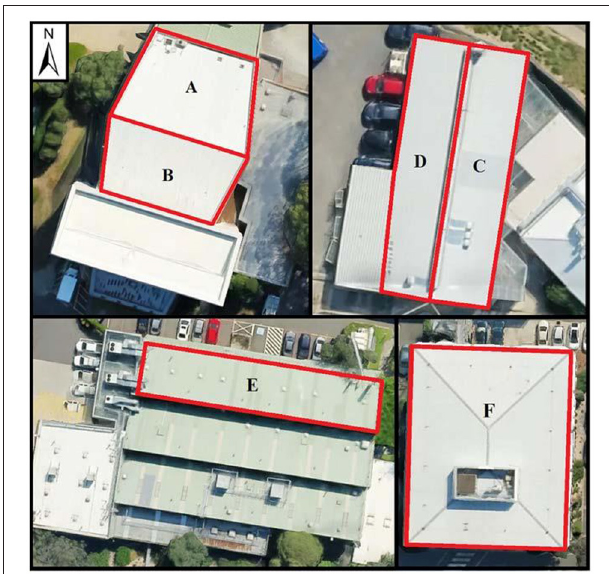
FIGURE 9 | Selected rooftops in the study